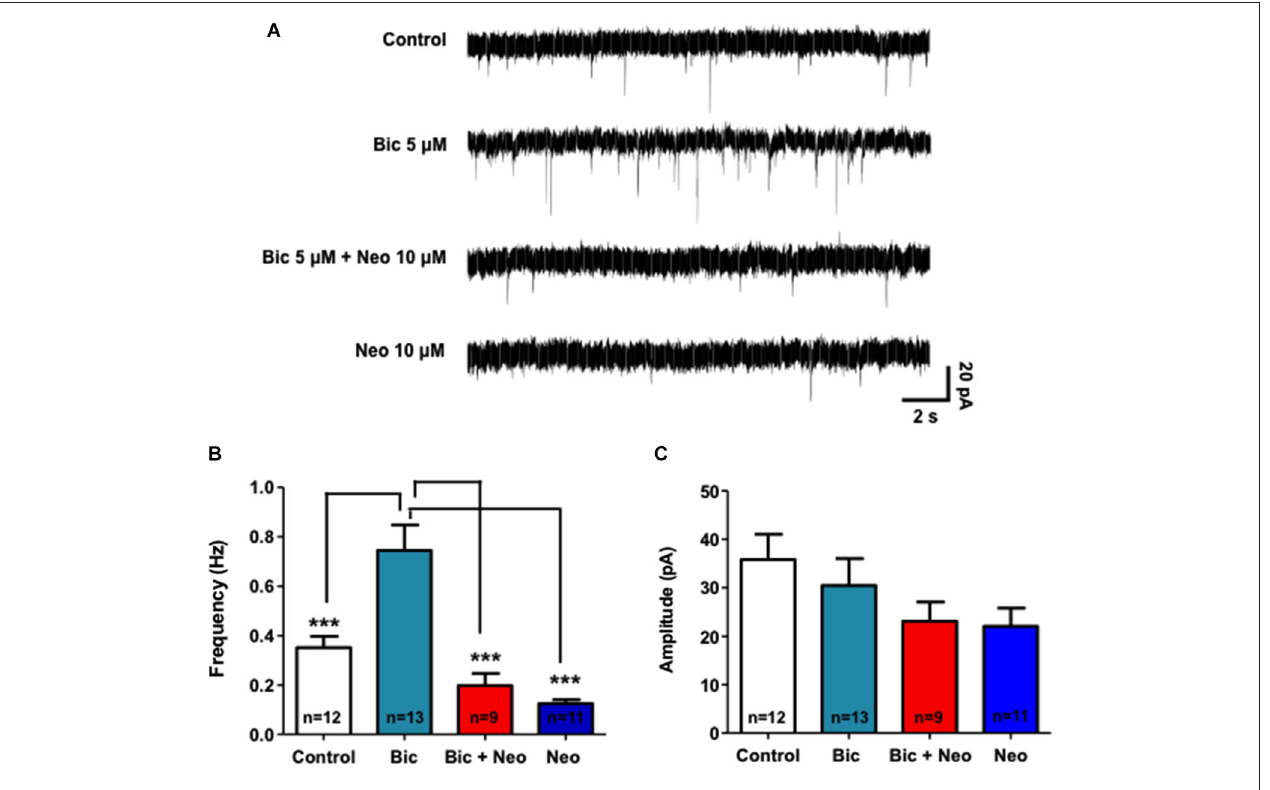
The graphs summarize the effect of the different treatments on the frequency (Hz) and amplitude (pA) of the records obtained in three independent experiments performed under the conditions described in “ (A) ”. Values are mean ± SEM obtained from the indicated number of neurons. ***, p <